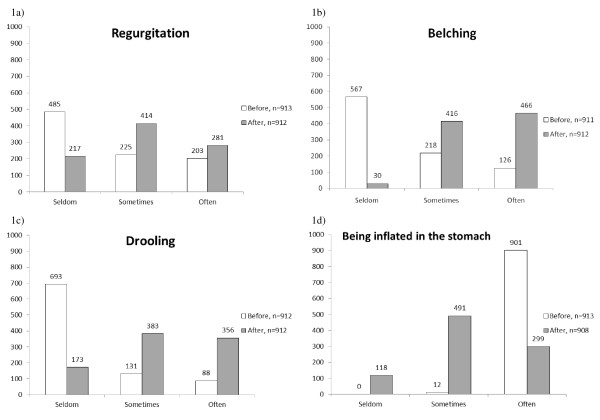
Frequency histograms of rated varied gastrointestinal symptoms.